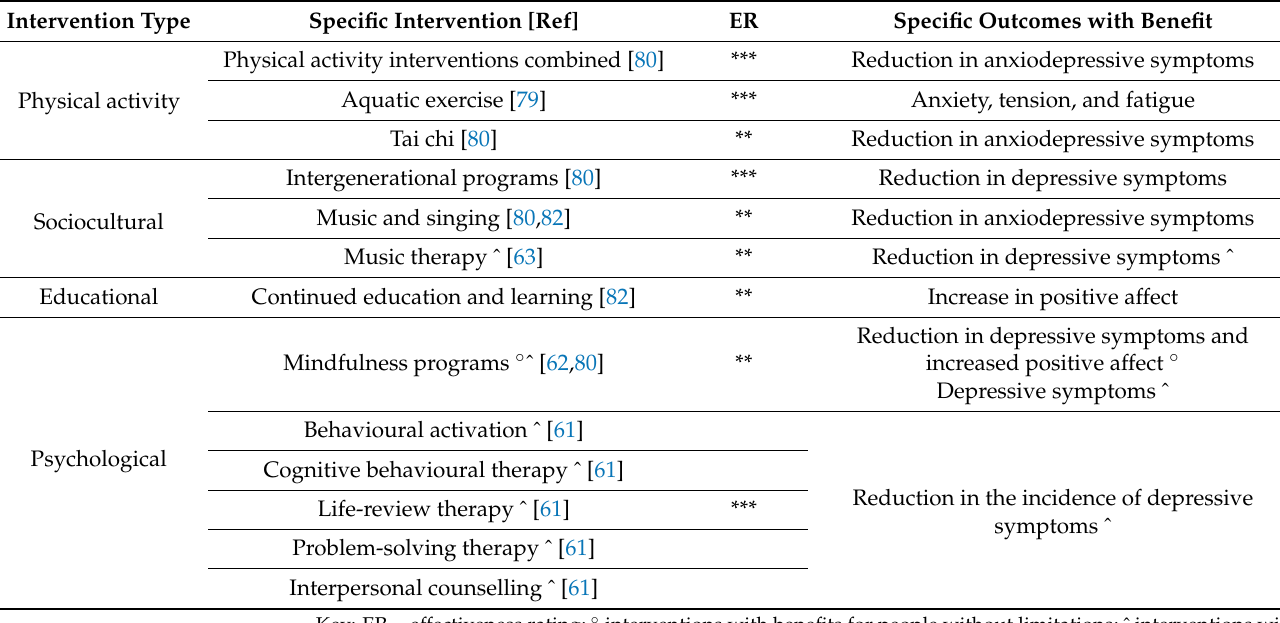
Table 5. Identified interventions for psychological